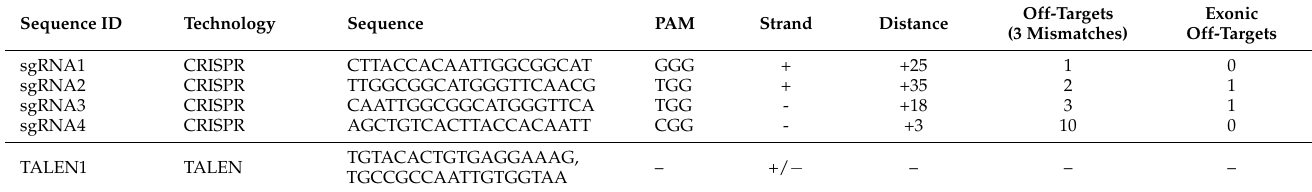
Table 1. sgRNA and TALEN guides designed for targeting PDE6C c.1670G>A